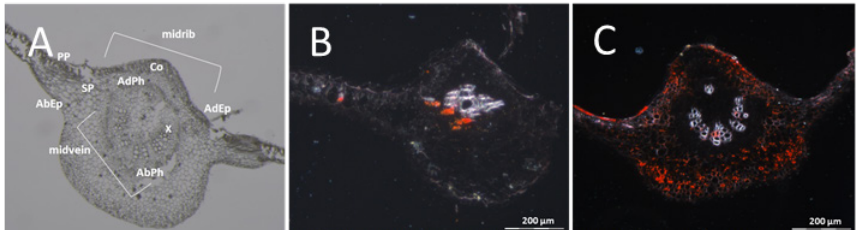
Figure 5. Distribution of CBSV-Mo83 RNA in cross sections of a cassava leaf from susceptible (Albert) and resistant lines. ( A ) Overview on the anatomy of a cassava leaf midrib. ( B ) Presence of the viral RNA mostly in the abaxial phloem cells in DSC 167 midvein. ( C ) Presence of viral RNA in phloem and non-phloem cells in Albert midvein. X, xylem; PP, palisade parenchyma; SP, spongy parenchyma; AdEp, adaxial epidermis; AbEp, abaxial epidermis; AbPh, abaxial phloem; AdPh, adaxial phloem; Co, collenchyma cells.